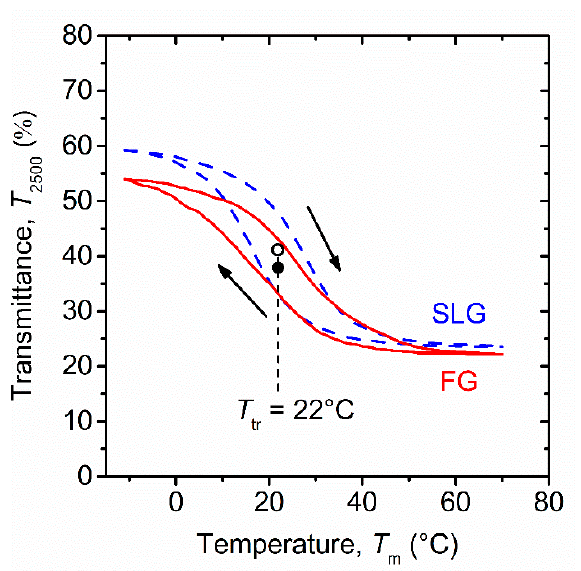
Figure 4. Temperature ( T m ) dependence of the transmittance ( T 2500 ) at 2500 nm for the ZrO 2 /V 0.984 W 0.016 O 2 /ZrO 2 coatings deposited on 0.1 mm thick FG and 1 mm thick SLG substrates (Figure 3). The transition temperature T tr = 22 °C is presented. Coatings 2020 , 10 , x FOR PEER REVIEW